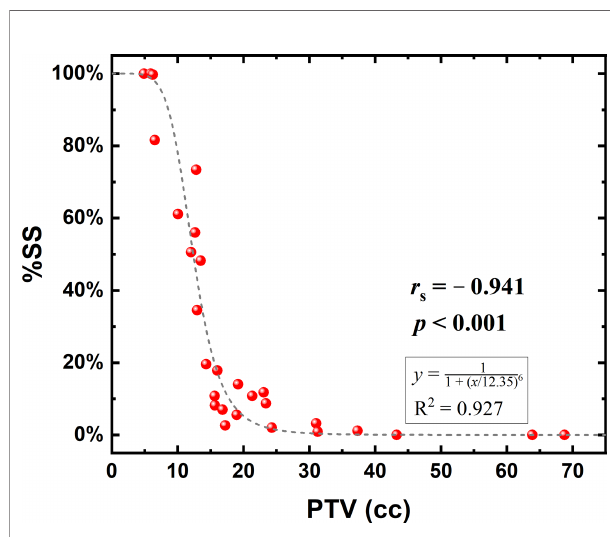
FIGURE 3 | Correlation between the planning target volume (PTV) and the percentage of small sub fi elds (%SS) in jaw tracking (JT)